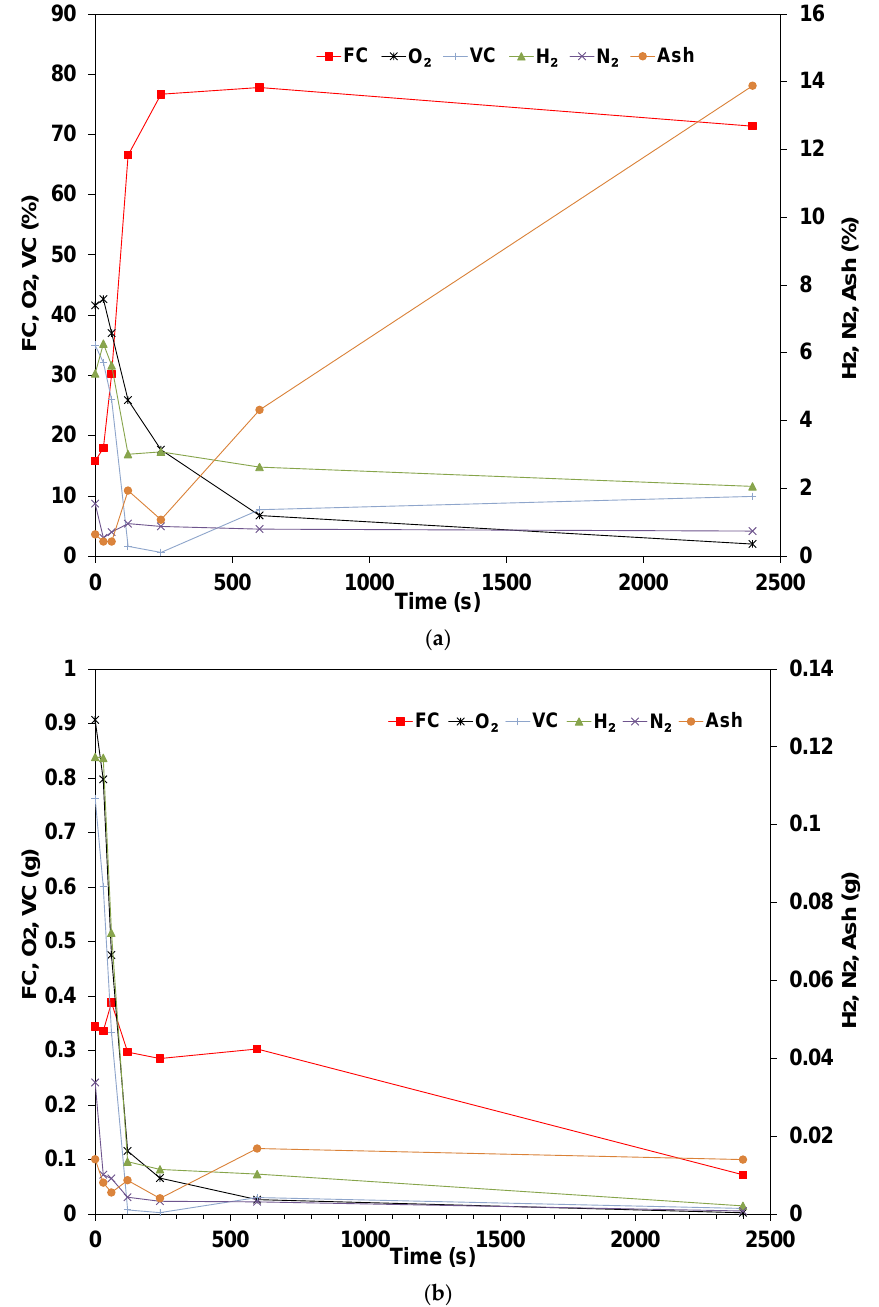
Figure 4. Elemental analysis of wood pellets at 650 °C: ( a ) in percentages and ( b ) in grams. After approximately 10 min, a steady reduction of volatiles is observed which, in the long run, approaches zero, coupled with a much slower oxidation of fixed Carbon. The ash content remains approximately constant, within the accuracy of the instrumentation.